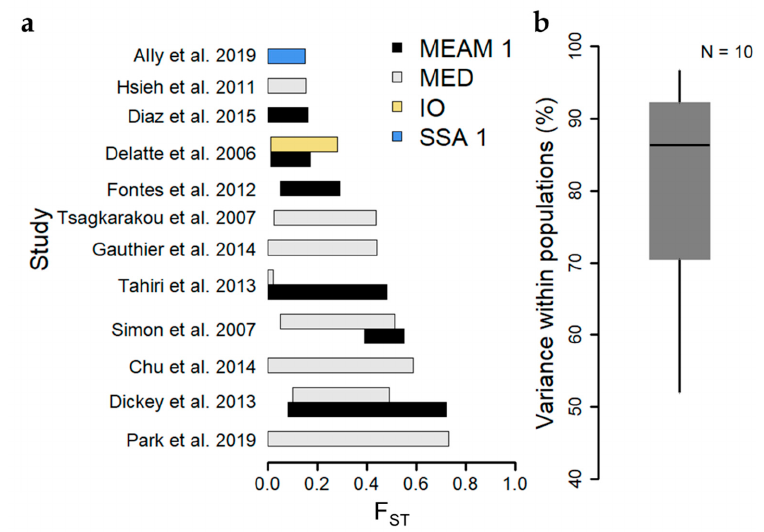
Figure 2. Summary of genetic differentiation among populations within cryptic species among microsatellite-based studies. ( a ) Barplots depict the range of pairwise fixation index (F ST ) reported among populations within cryptic species and studies. “MEAM 1” stands for Middle East-Asia Minor 1; “MED” stands for Mediterranean; “IO” stands for Indian Ocean; “SSA 1” stands for Sub-Saharan Africa 1. ( b ) Boxplot depicts the distribution of reported values of the percentage of genetic variance partitioned within populations. Boxplots depict the median (thick line), 25th and 75th percentiles (box edges), and 95th percentiles (whiskers).